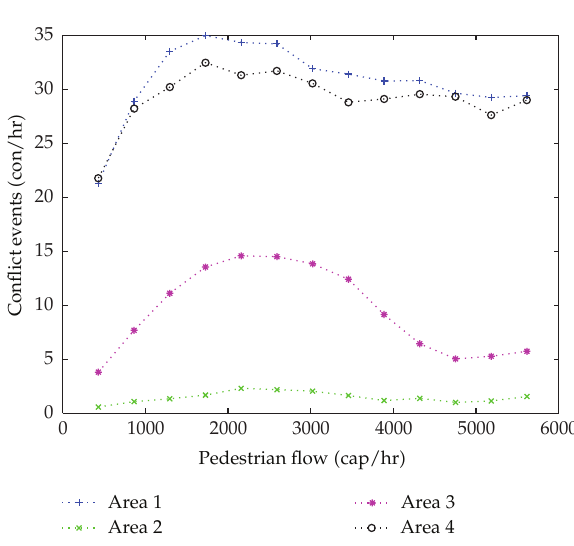
Figure 7: The conflict events in four areas with green light time 35s and crosswalk width 3m. Table 1: The pedestrian conflict delay and red light